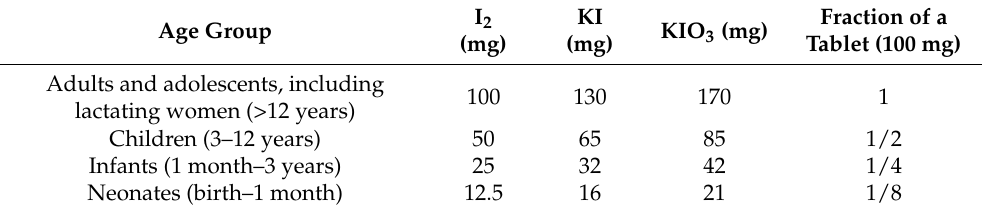
Table 2. Recommended iodine dosage as prophylaxis by age group [287]. Age